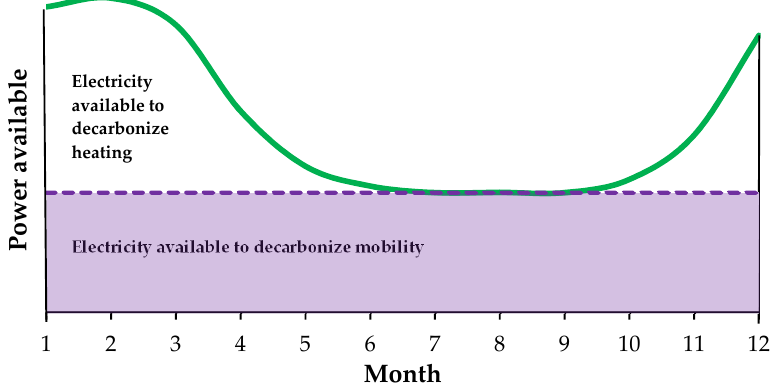
Figure 5. Generic energy profile produced by upgrading to a low-energy solar building showing the portions available for mobility and heating decarbonization.